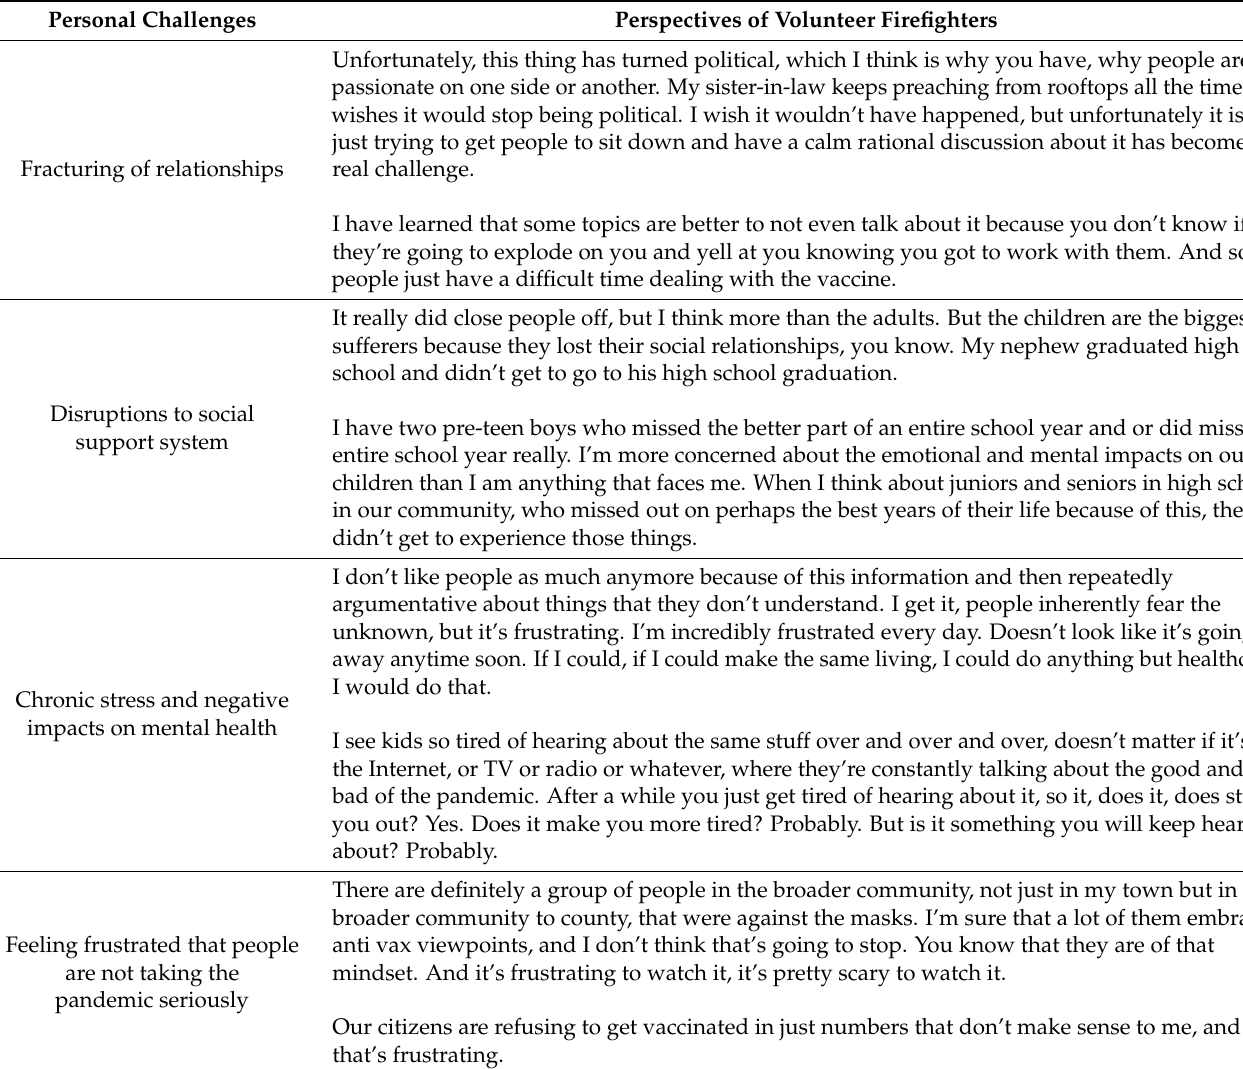
Table 3. Personal Stumbling Blocks Related to the COVID-19